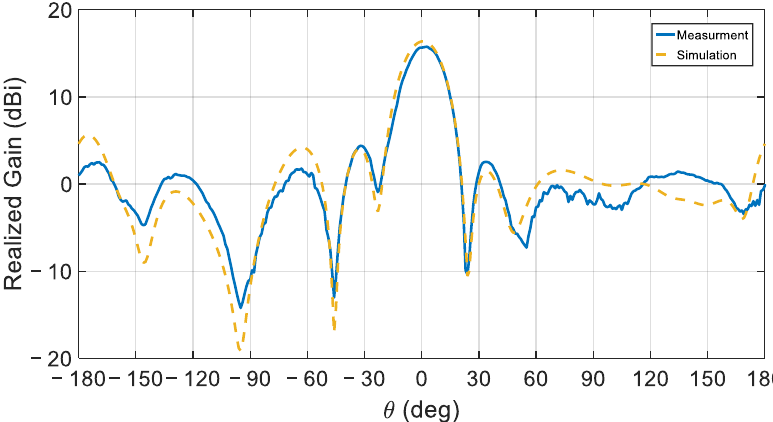
Figure 15. E- and H-plane radiation pattern at 28.52 GHz for the proposed CDRA array.